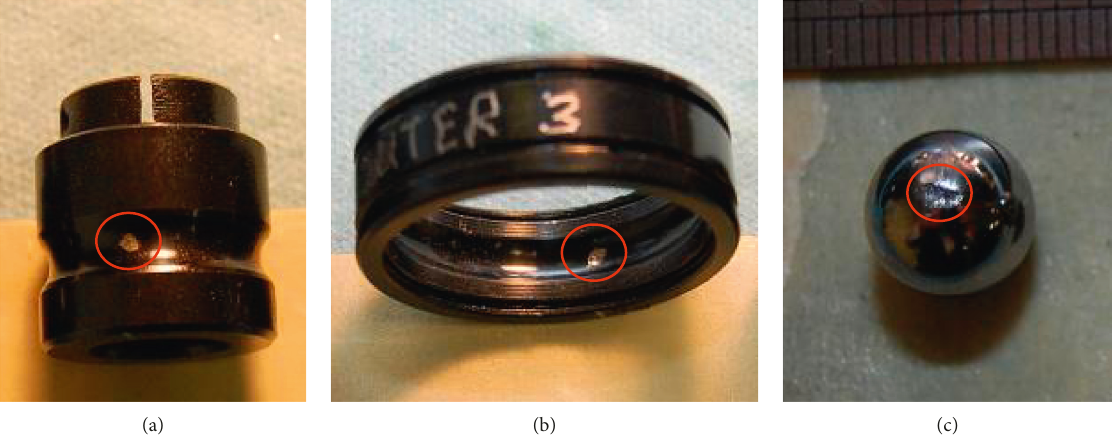
Figure 4: Pictures of the bearing faults: (a) IF; (b) OF; (c) BF. Table 1: Description of bearing datasets for fault classification. Dataset